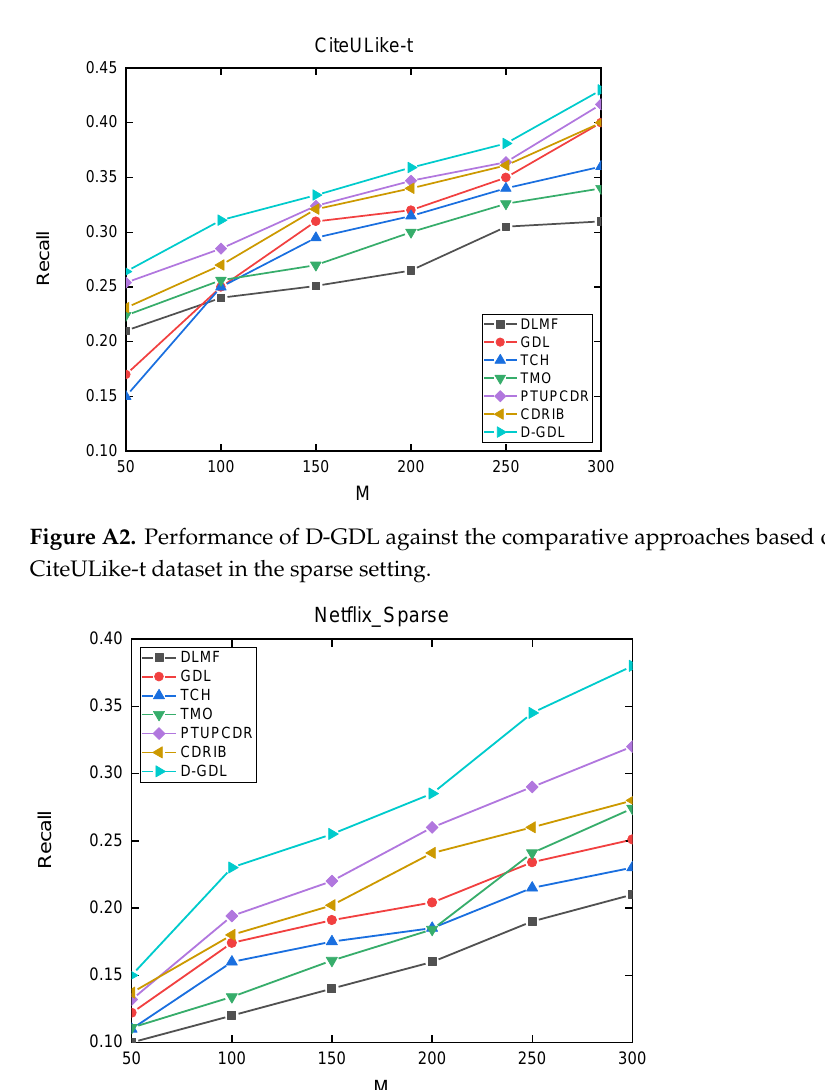
Figure A1. Performance of D-GDL against the comparative approaches based on Recall vs. M for CiteULike-a Dataset in the Sparse Setting.